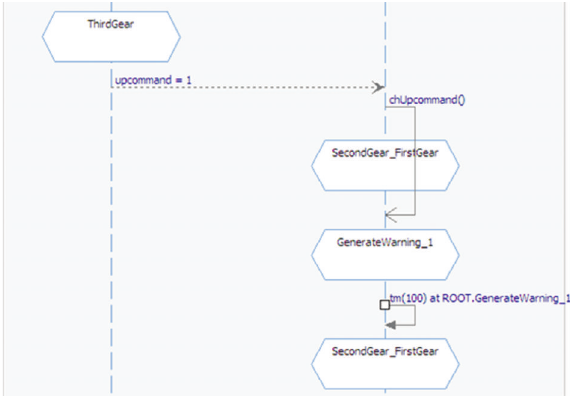
Figure 23: Another part of generated sequence diagram.